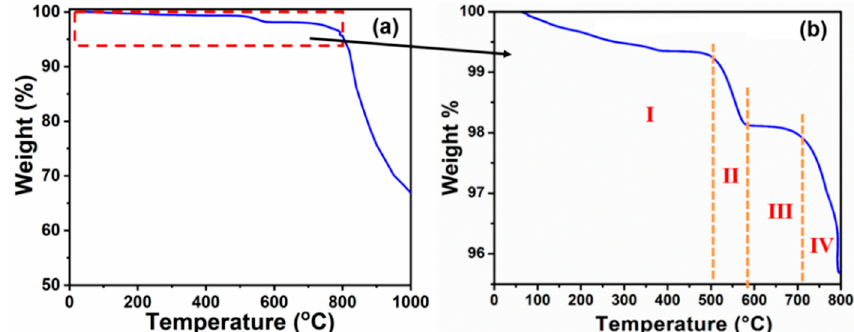
Figure 4. ( a , b ) TGA plot of the synthesized mesoporous Mn 2 O 3 materials.